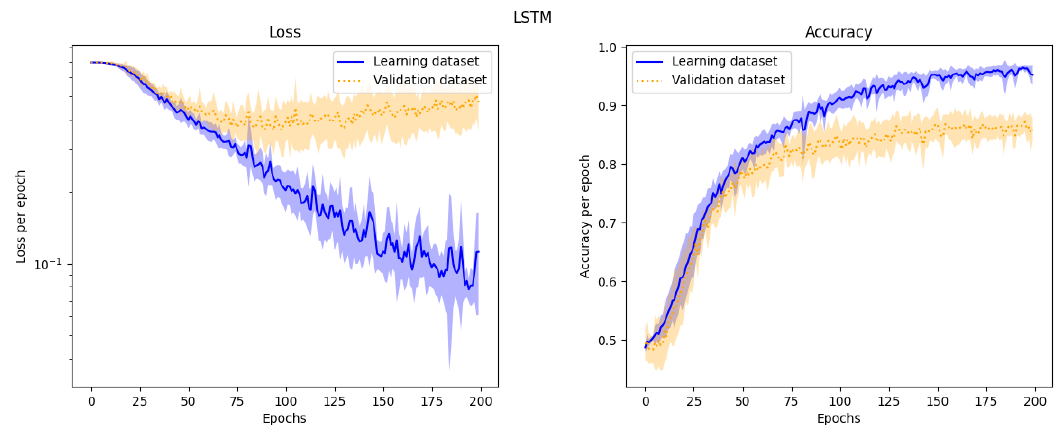
Figure 3. Average loss and accuracy of the models with LSTM over learning